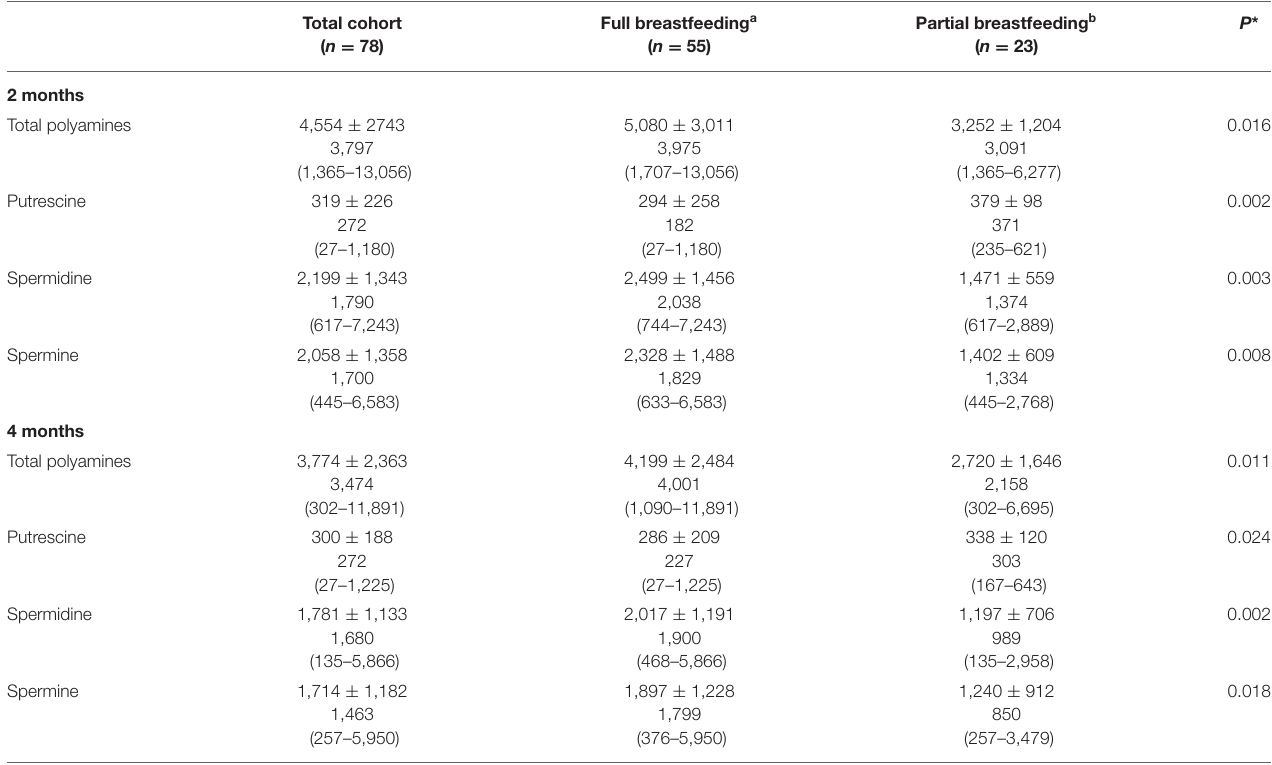
TABLE 3 | Estimation of polyamine intake of the infant according to the type of